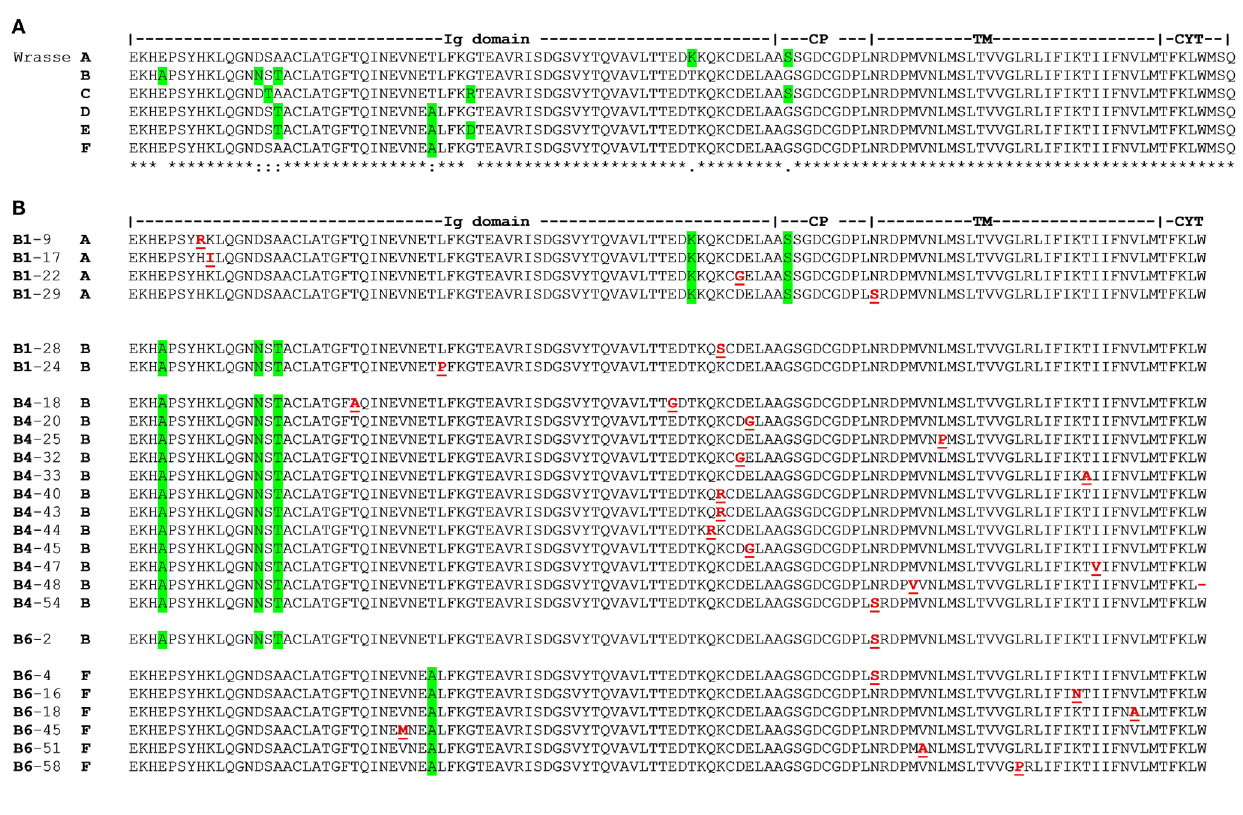
FigUre 4 | T cell receptor (TCR) C α allotypes and somatic replacement mutations in Ballan wrasse. (a) TCR C α allotypes in Ballan wrasse. Allotypes were found by analysis of scaffold 928 and 4467, intestinal transcriptome data from 34 Ballan wrasse individuals, and 79 cDNA clones from three wild fish (B1, B4, and B6). Green highlights residues which characterize each allotype. (B) Alignment and positioning of somatic replacement mutations found in TCR C α of individuals B1, B4, and B6. Mutations are underlined in red. Accession numbers are given in Table S10 in Supplementary